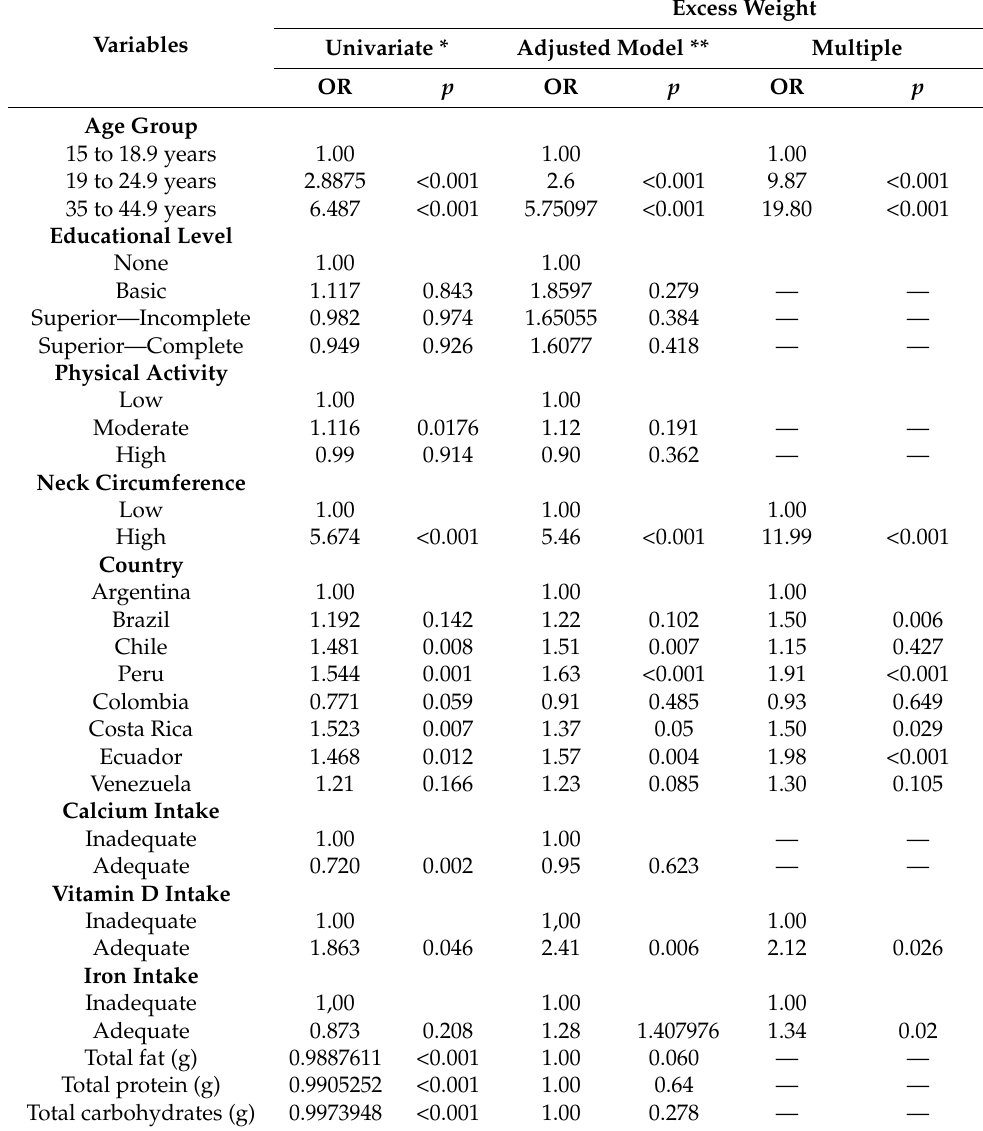
Table 6 presents associations between the risk of excess weight and different predictors. Age group, neck circumference, country of residence, and vitamin D and iron intake were relevant predictors in the final regression model. Women aged 19 to 24.9 years had a 9.87-fold higher risk for excess weight and those aged 35–44.9 years had a 19.80-fold higher risk for excess weight than female adolescents. An increased neck circumference predicted a 12-fold increase of obesity risk. Table 6. Association between excess weight and characteristics of childbearing-age women in the Latin American Study of Nutrition and Health (ELANS), 2015. Excess Weight Variables Univariate * Adjusted Model ** Multiple